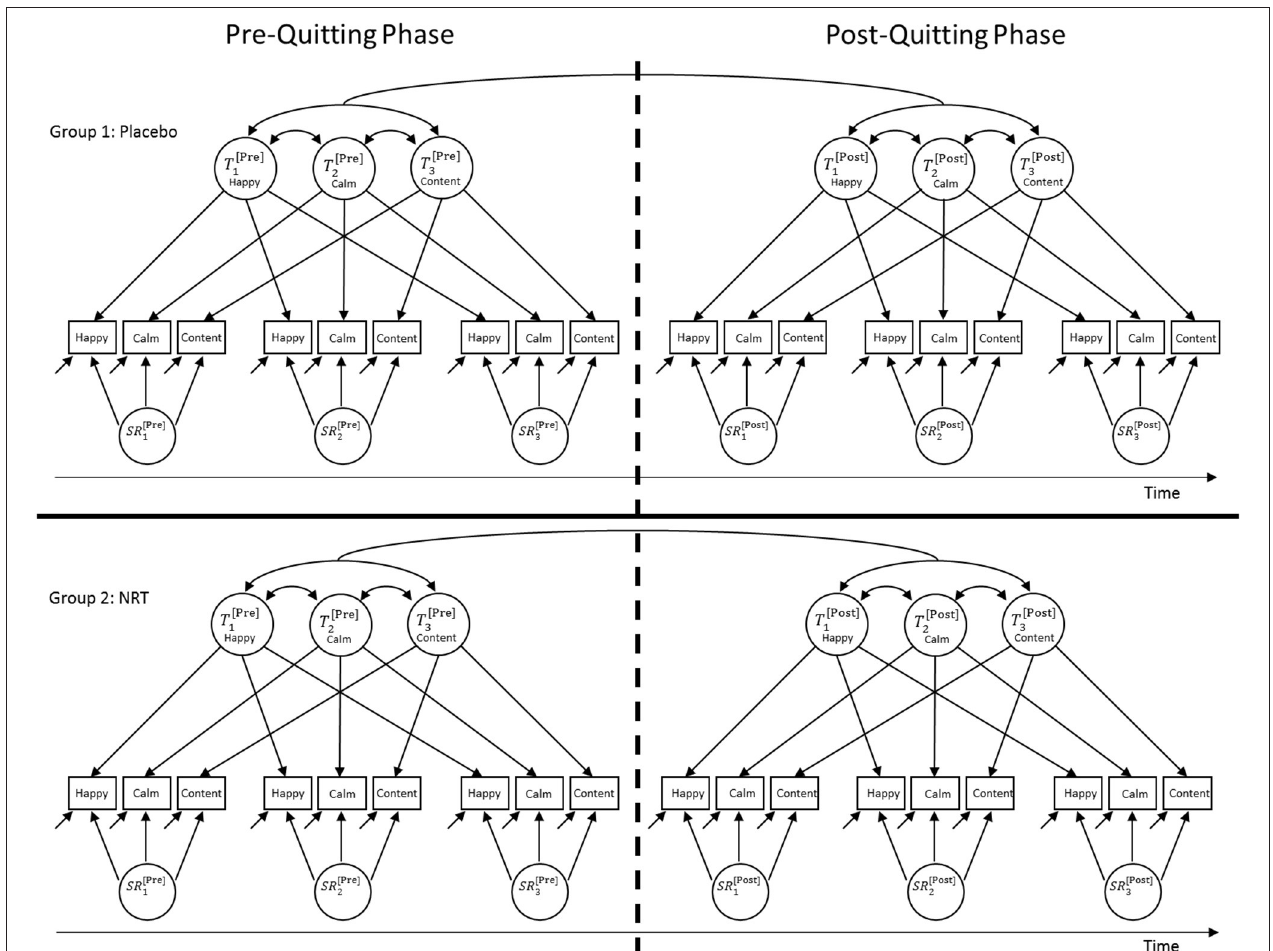
FIGURE 3 | Path diagram of a multigroup-multiphase-(MG-MP-)LST model for three indicators measured on three time points pre- and post an intervention (here: quitting smoking) in two groups (here: placebo vs. NRT). All indicator-specific trait factors can be correlated within and across phases.